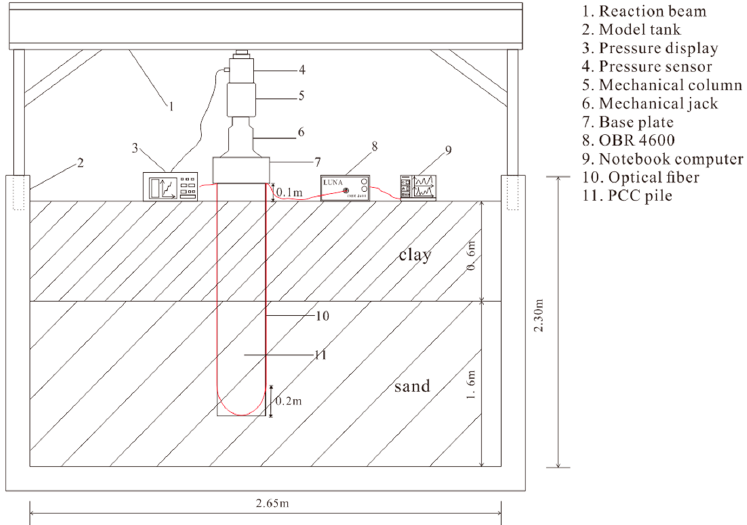
Figure 2. Schematic diagram of the experiment.